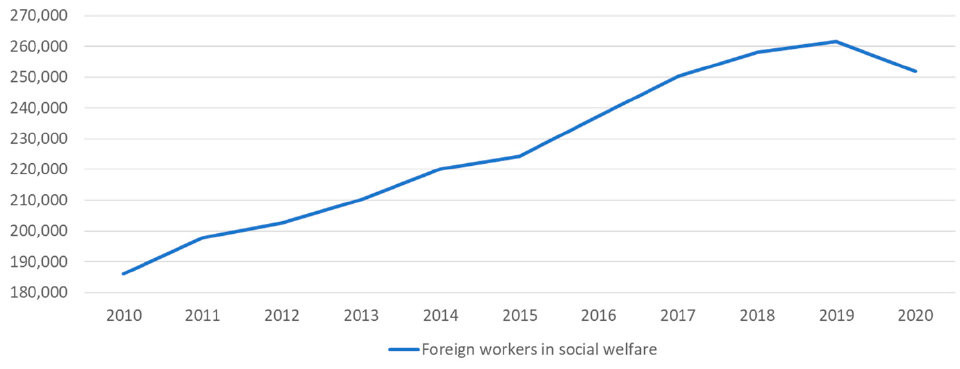
Figure 2. Foreign domestic workers from 2010 to 2020 [1]. Data source: adapted from https://english.mol.gov.tw/21004/21107/21113/lpsimplelist (accessed on 30 January 2022).